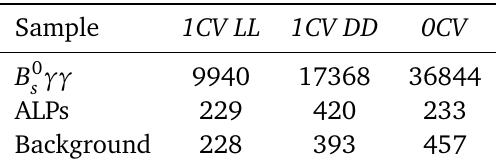
Table 3: Sample sizes for the signal decays and background after reconstruction and trigger